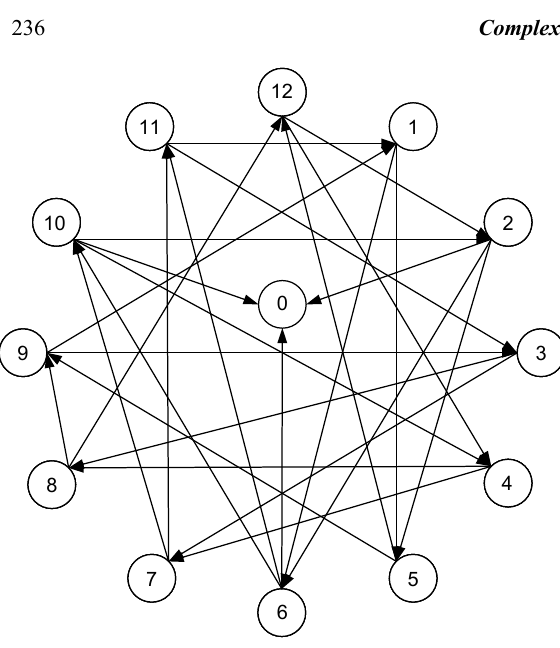
Fig. 5 Flow model converted from a four-satellite